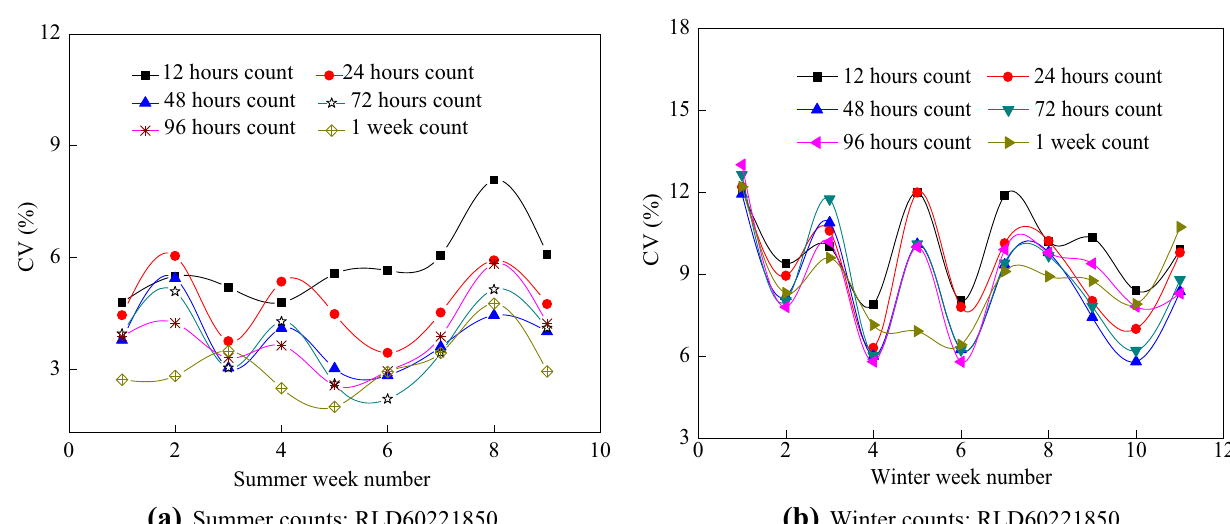
Fig. 2 CV values for all SDCs during summer and winter for RLD60221850